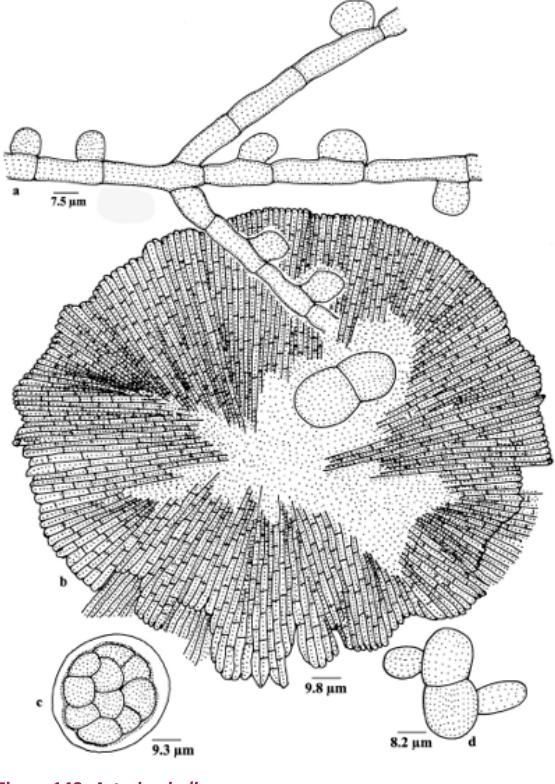
Figure 147. Asterina hibisci a - Appressorium; b - Thyriothecium; c - Ascus; d - Ascospores